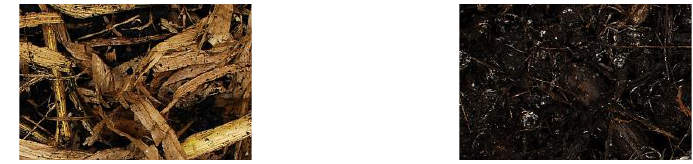
Figure 2. Example images taken at the beginning ( left ) and the end ( right ) of each composting experiment ( a — experiment 1; b — experiment 2; c — experiment 3; d — experiment 4; e — experiment 5; f — experiment 6; g — experiment 7; h — experiment 8).